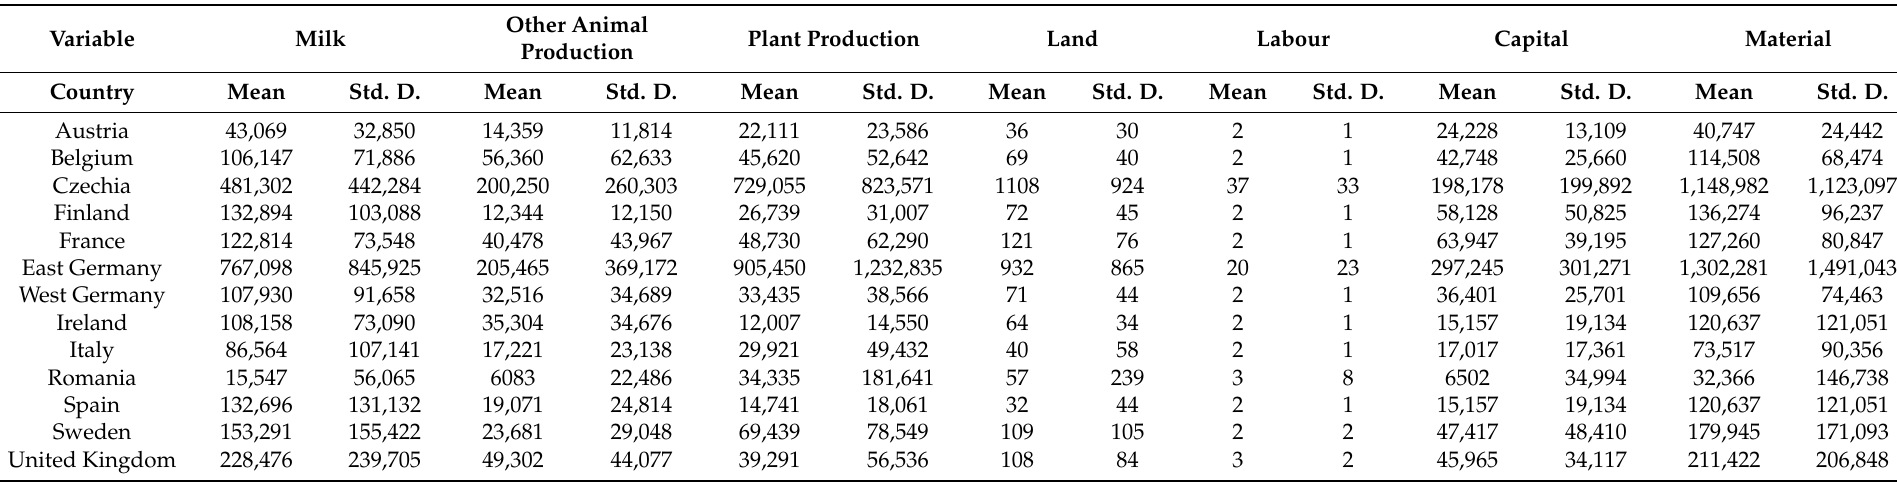
Table 2. Descriptive statistics. Source: FADN database and own